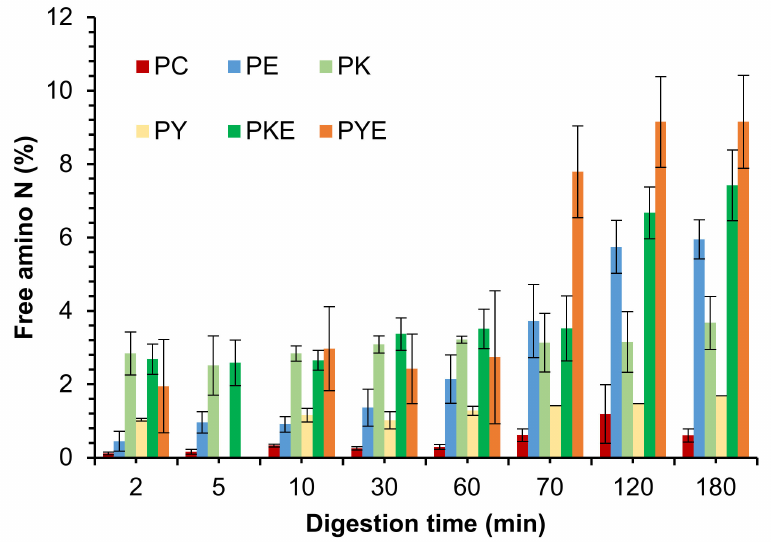
Figure 5. Free amino N (%) release during simulated gastro-small intestinal digestion of pea protein isolate in the presence or absence of Hayward or SunGold kiwifruit extract. PC, Pea protein (P) control without any digestive enzymes; PK/PY, with added kiwifruit extract but no digestive enzymes; PE, with digestive enzymes but no added kiwifruit extract; PKE/PYE, with both digestive enzymes and green/gold kiwifruit extract. The number 60 is the gastric digestion time following 2 min of oral digestion. Numbers 70, 120 and 180 are the total digestion times in oral-gastro-small intestinal digestion (including 60 min of gastric